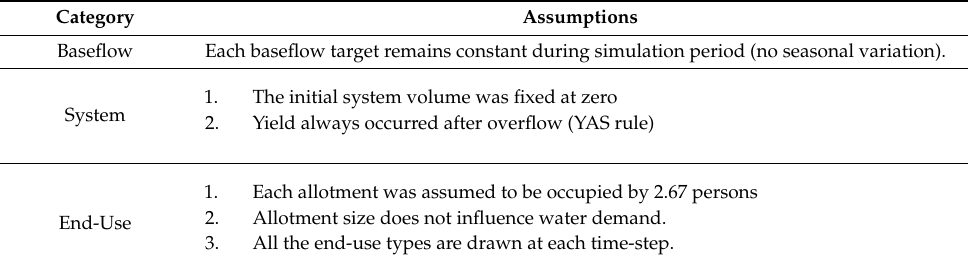
Table 1. Table of model assumptions.